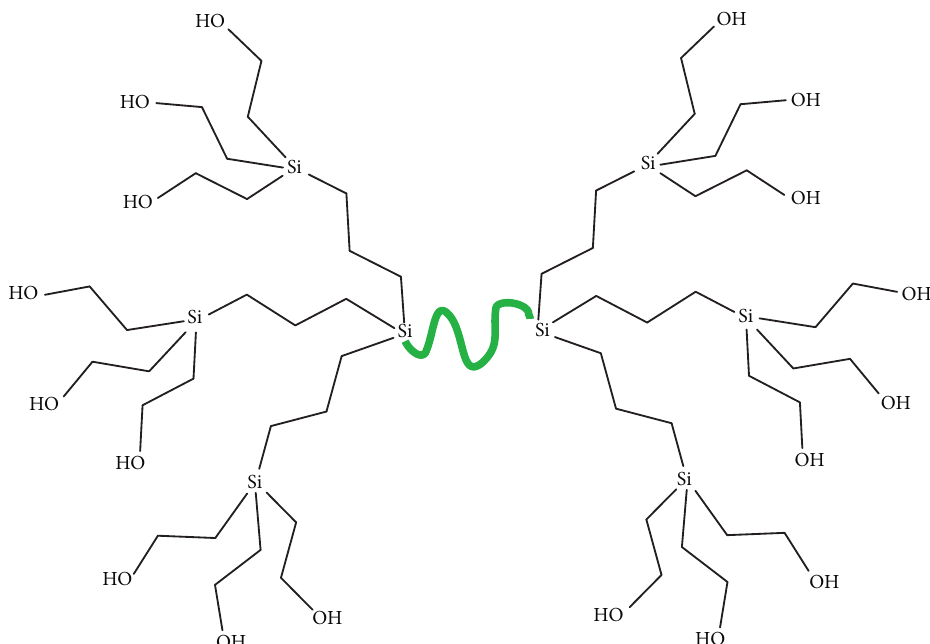
Figure 2: PEG-cored carbosilane dendrimer [16].